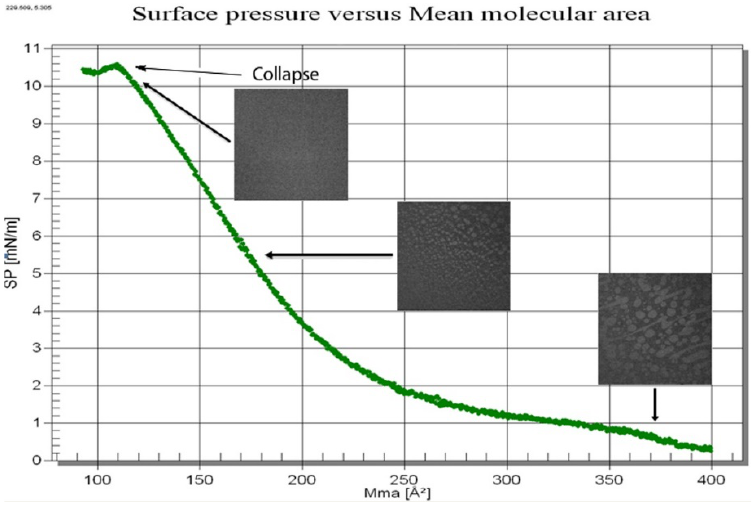
Figure 4. Surface pressure (mN/m)-area (Å2) isotherm of the copolymer at 24 °C on a pure-water subphase.